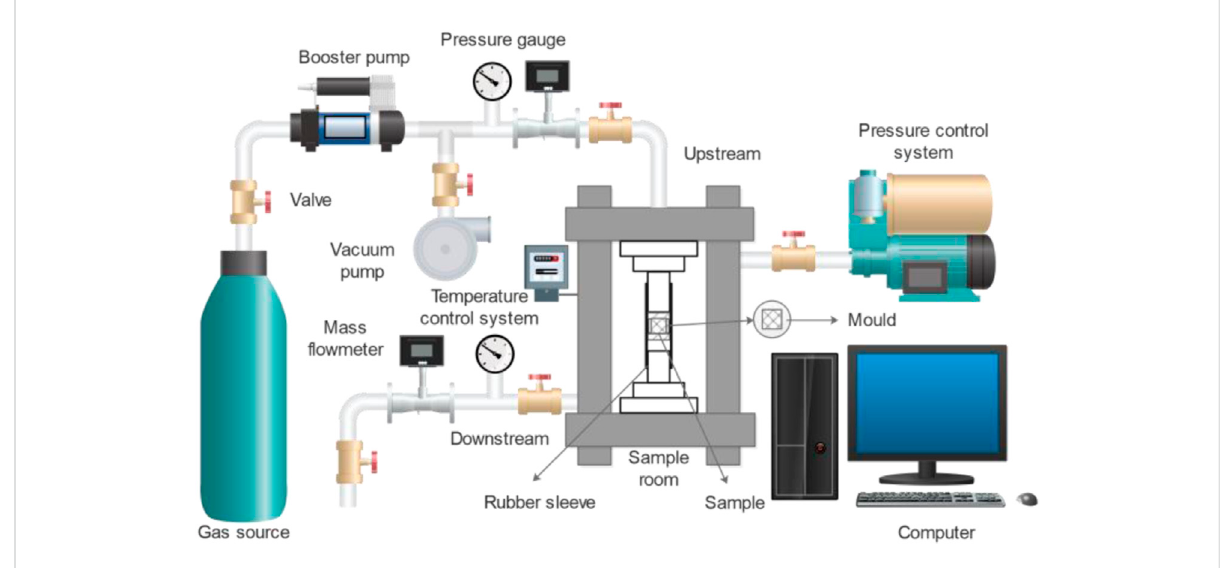
FIGURE 1 The anisotropic permeability testing